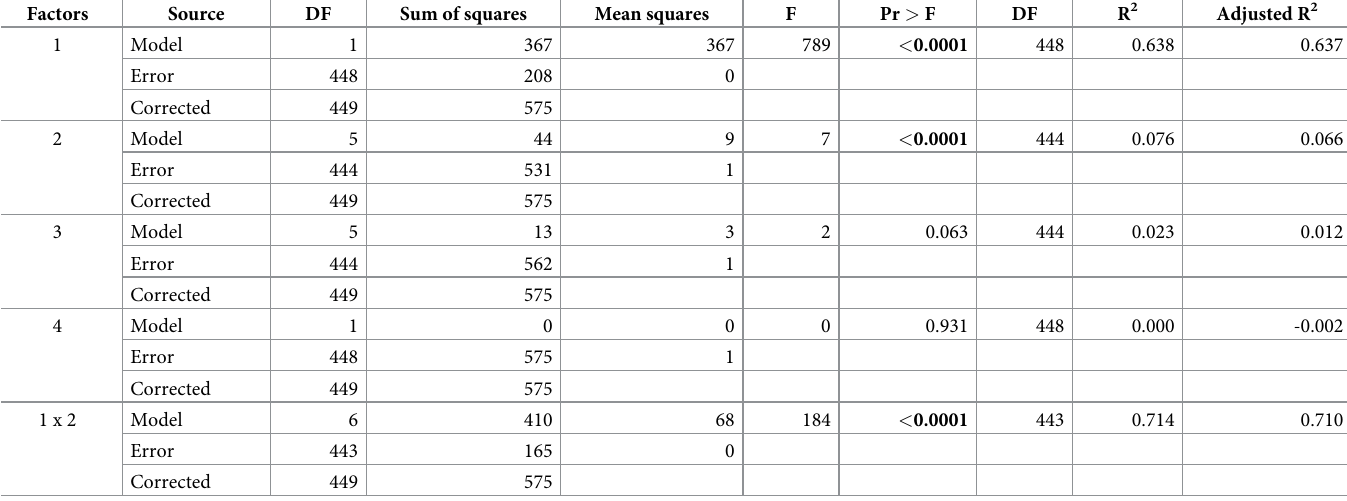
Table 8. ANOVA table for the dimensionless parameter LER%CL of the dorsal fin and tail fluke cross-sections with the independent factors fin type (Factor 1), sec- tion # (Factor 2), species (Factor 3) and body length (Factor 4).